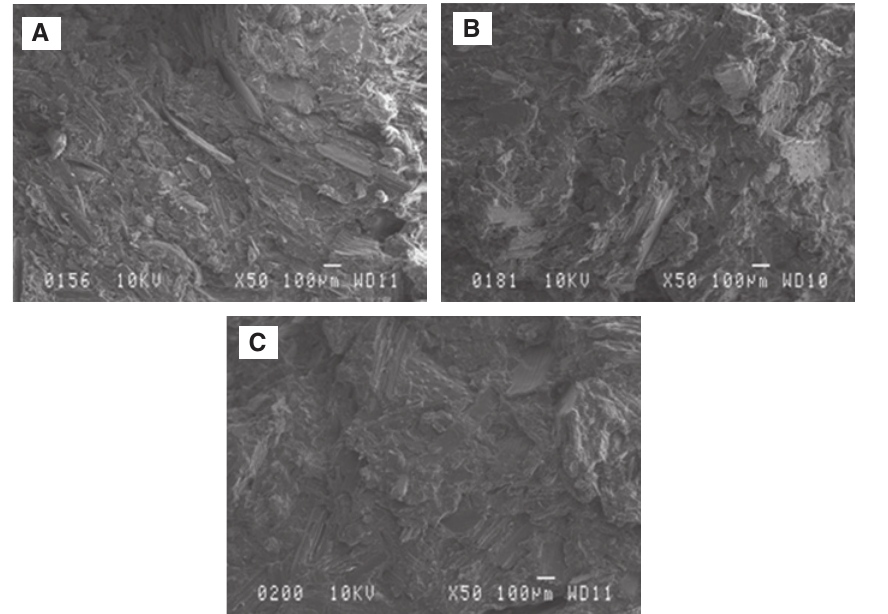
Figure 13 Fracture surface of PP triticale composites: (A) 30% triticale without coupling agent, (B) 30% triticale with coupling agent, and (C) 30% triticale with coupling agent and CaO.